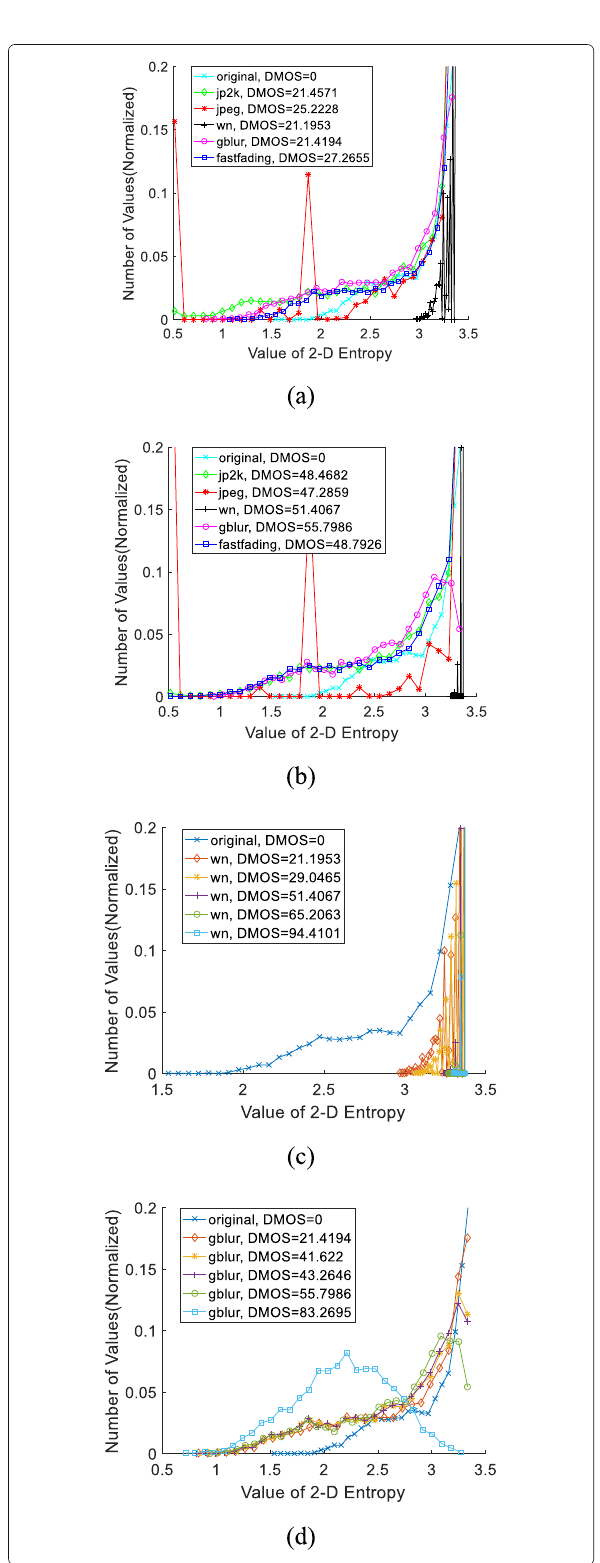
Fig. 3 Histograms of TE values. a The six curves correspond to an undistorted image and its distorted counterparts with the same distortion level but different distortion types. The DMOS values are around 25. b The six curves correspond to an undistorted image and its distorted counterparts with the same distortion level but different distortion types. The DMOS values are around 50. c The six curves correspond to an undistorted image and its distorted counterparts with the same distortion type but different distortion levels. The distortion type is WN. d The six curves correspond to an undistorted image and its distorted counterparts with the same distortion type but different distortion levels. The distortion type is